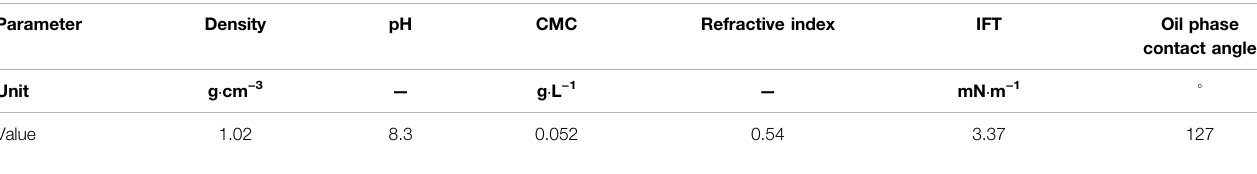
TABLE 2 | Surfactant basic performance used for imbibition test.